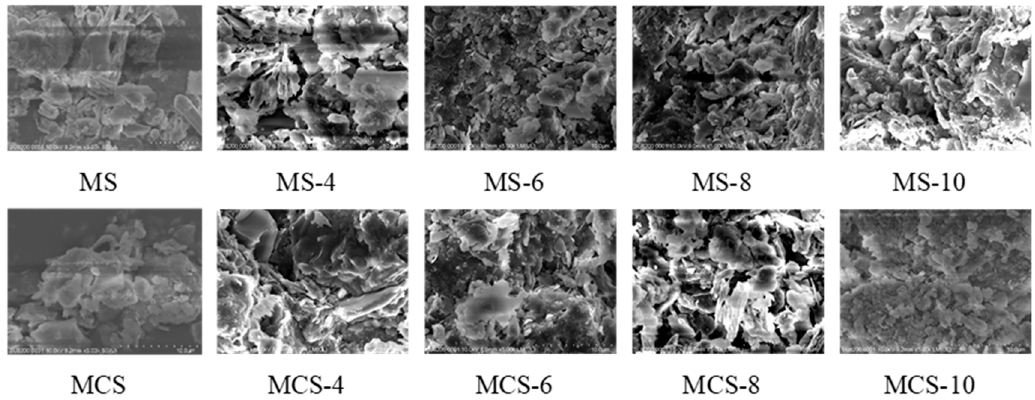
Figure 13. SEM images of gangue after leaching with mine water at different pH values.